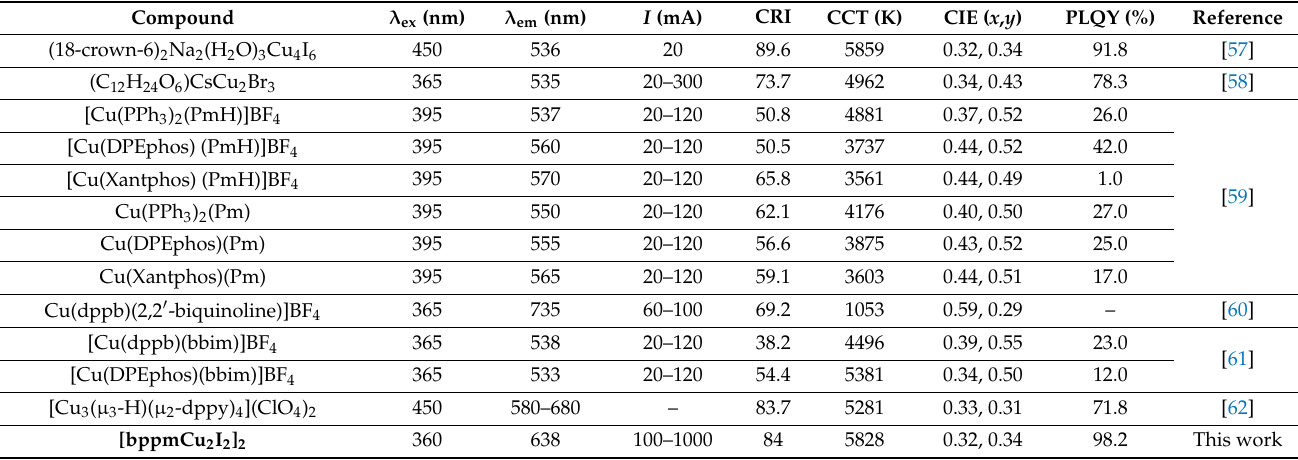
Table 1. The performance of related Cu(I) complexes for LED